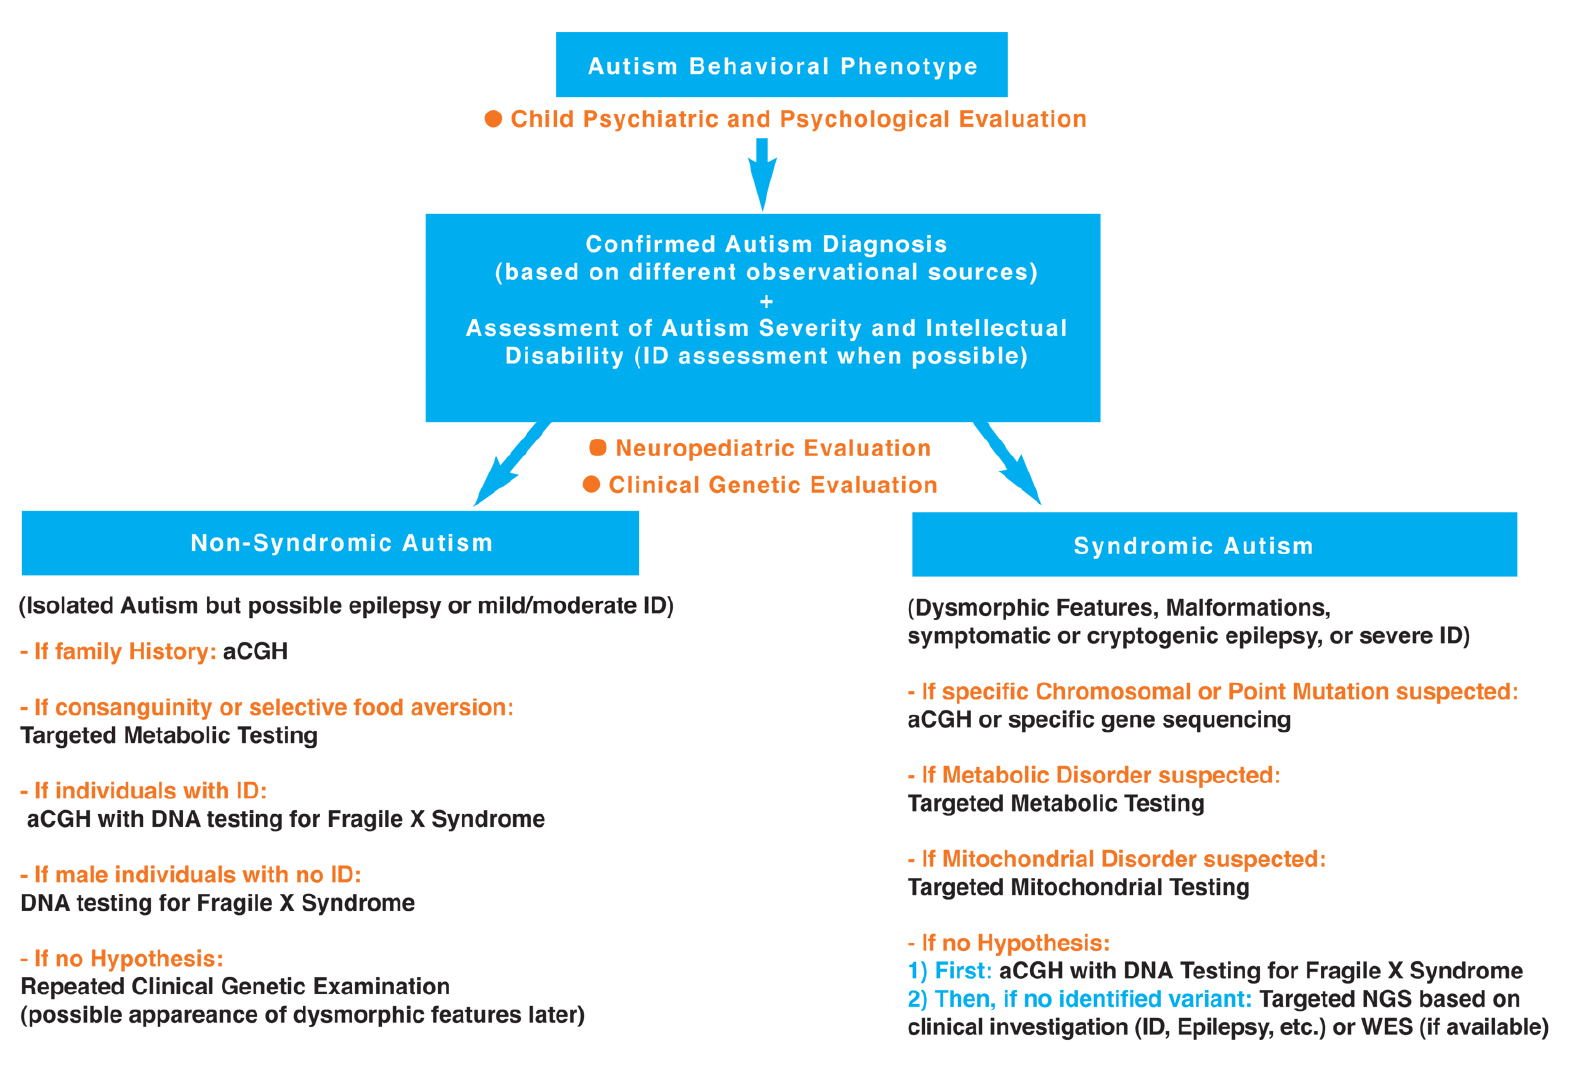
Figure 1. Hierarchical diagnostic strategy with a stepwise evaluation towards identification of genetic disorders associated with autism.